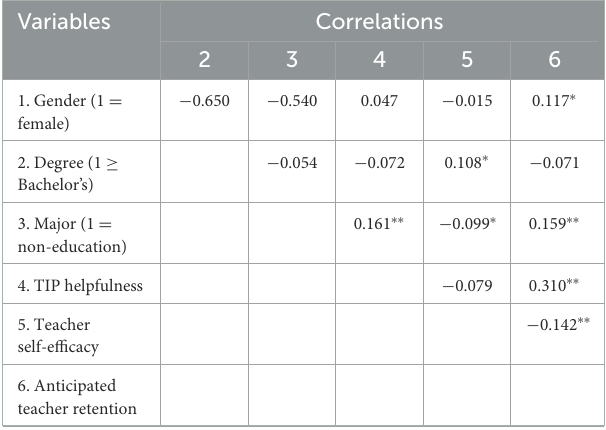
TABLE 1 Descriptive statistics and Pearson correlations between key variables in the regression models with control